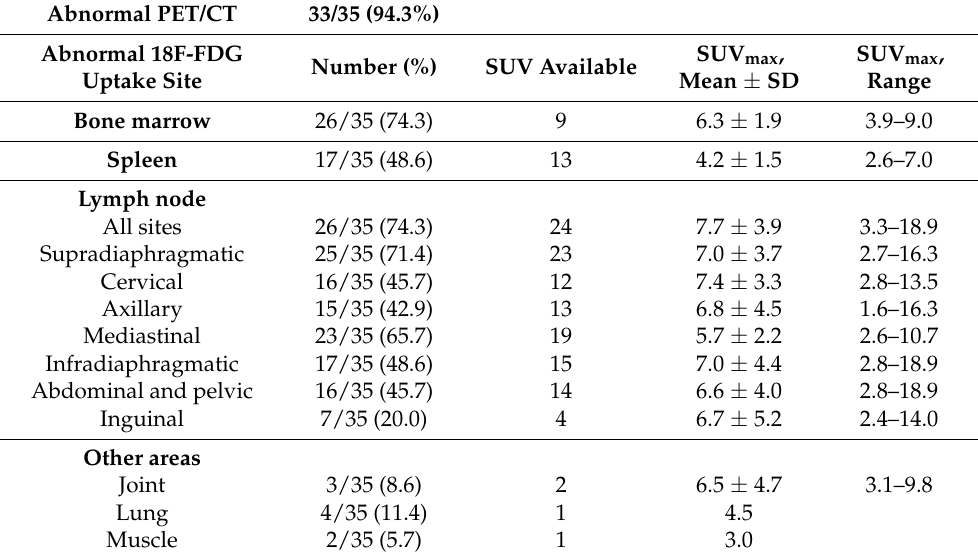
Table 2. 18F-FDG-PET/CT characteristics in 35 AOSD patients.